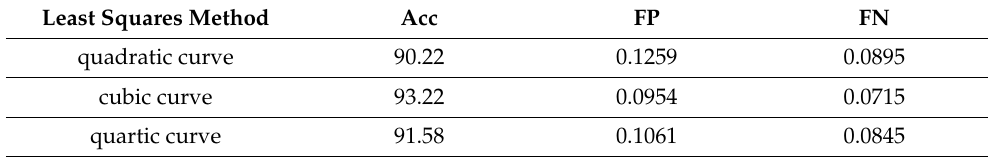
Table 4. Quantitative evaluation of different lane shape models on TuSimple validation set (%). Least Squares Method